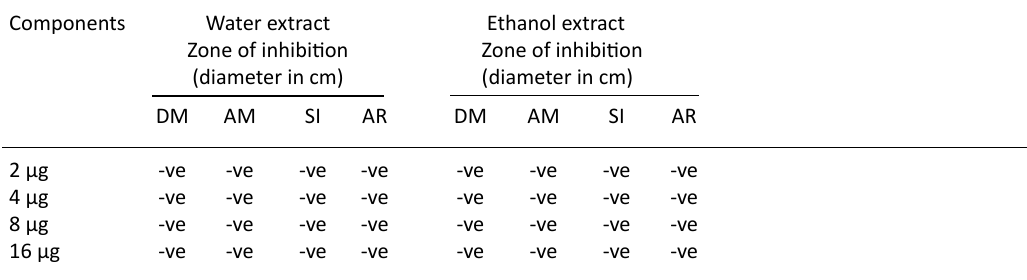
Table 3. Antibacterial activity of green synthesized silver nanoparticles Components